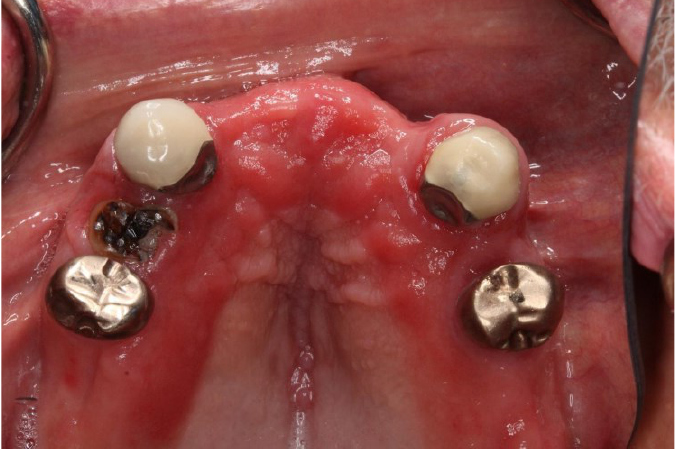
Figure 6. Clinical manifestations of Candida albicans sp. fungal infection characterized by the redness (erythema) on the denture base adaptation (saddle) area. In this case, it was aggravated by poor oral hygiene, periodontal disease, and the presence of an untreated root stump.